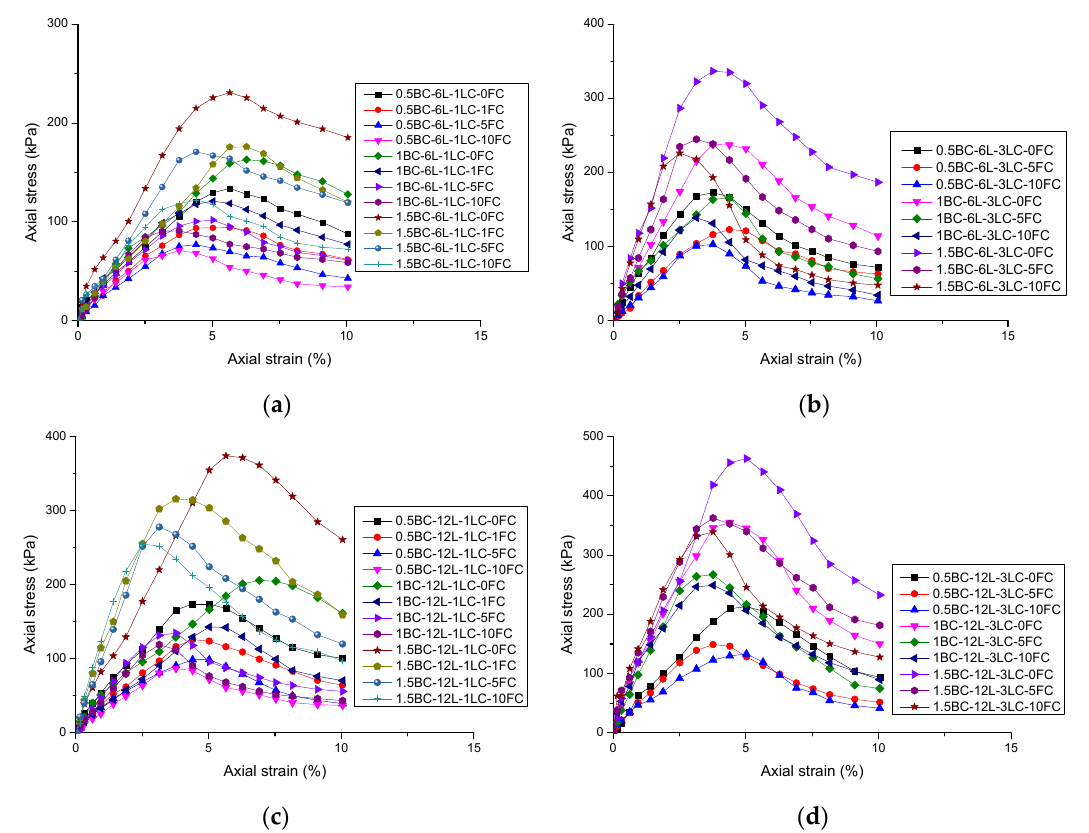
Figure 5. Stress–strain curves of reinforced loess samples with different basalt fiber and lime contents: ( a ) BC = 0.5, 1 and 1.5%, L = 6 mm, LC = 1%; ( b ) BC = 0.5, 1 and 1.5%, L = 6 mm, LC = 3%; ( c ) BC = 0.5, 1 and 1.5%, L = 12 mm, LC = 1%; and ( d ) BC = 0.5, 1 and 1.5%, L = 12 mm, LC = 3%.